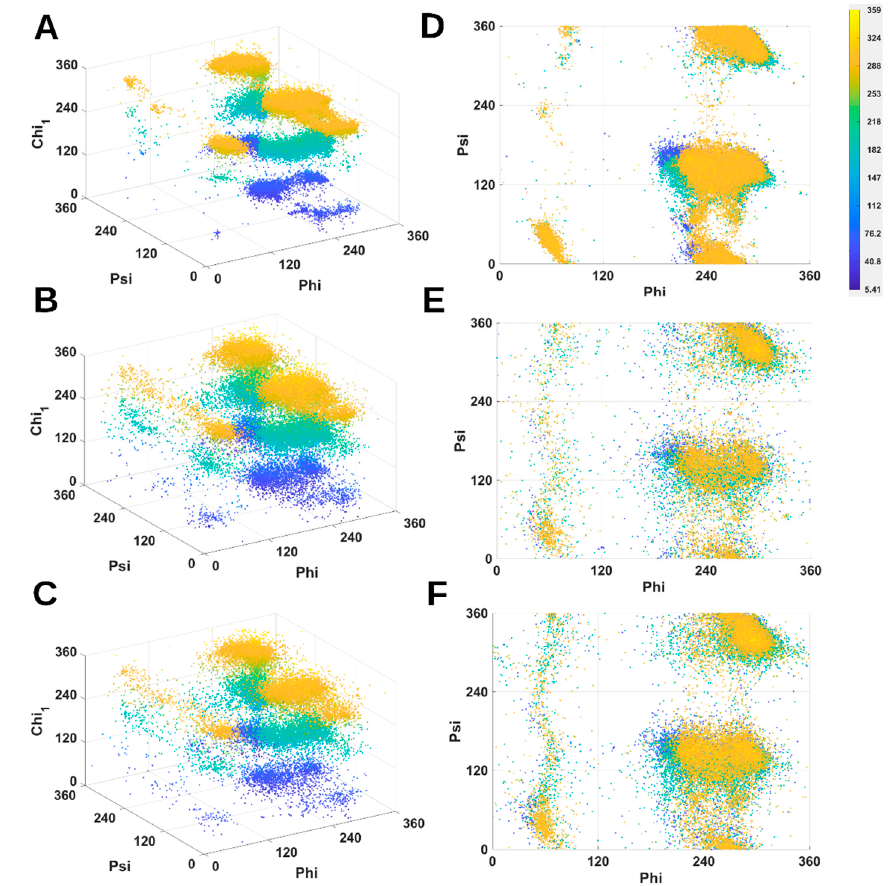
Figure 1. 3D scatter plots and Ramachandran plots of Arginine (ARG) residue for three data sets. 3D scatter plots of ( φ , ψ , χ 1 ) are shown for X-ray-1.5 data set ( A ); EM-2-4 data set ( B ); and EM-4-6 data set ( C ); Ramachandran plots of ( φ , ψ ) are shown for X-ray-1.5 data set ( D ); EM-2-4 data set ( E ); and EM-4-6 data set ( F ). The color code (shown) is based on χ 1 , and it is the same for each panel.